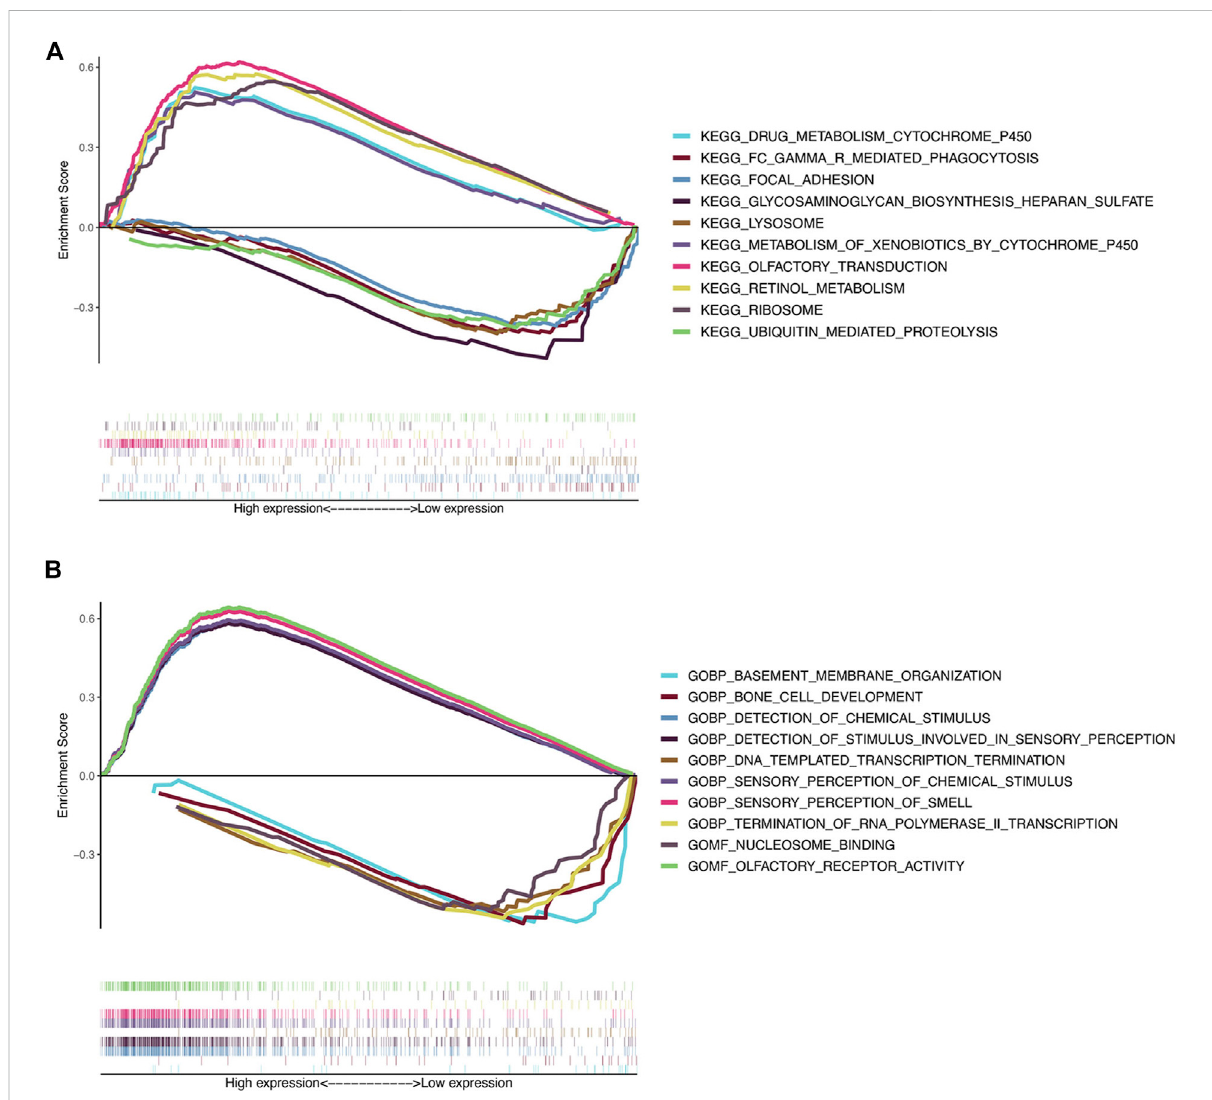
FIGURE 6 Genesetenrichmentanalysis. (A) Top fi veKEGGpathwaysinthehigh-riskgroup(abovethehorizontalline)andinthelow-riskgroup(belowthe horizontalline). (B) Top fi